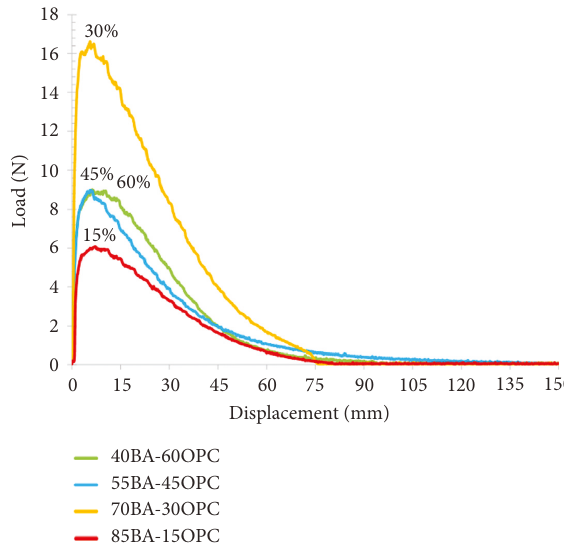
Figure 10: Load-displacement curve of DENT test with doubled- edge notches of 10mm for OPC at 15 o C and speed rate of 25 mm/ min.